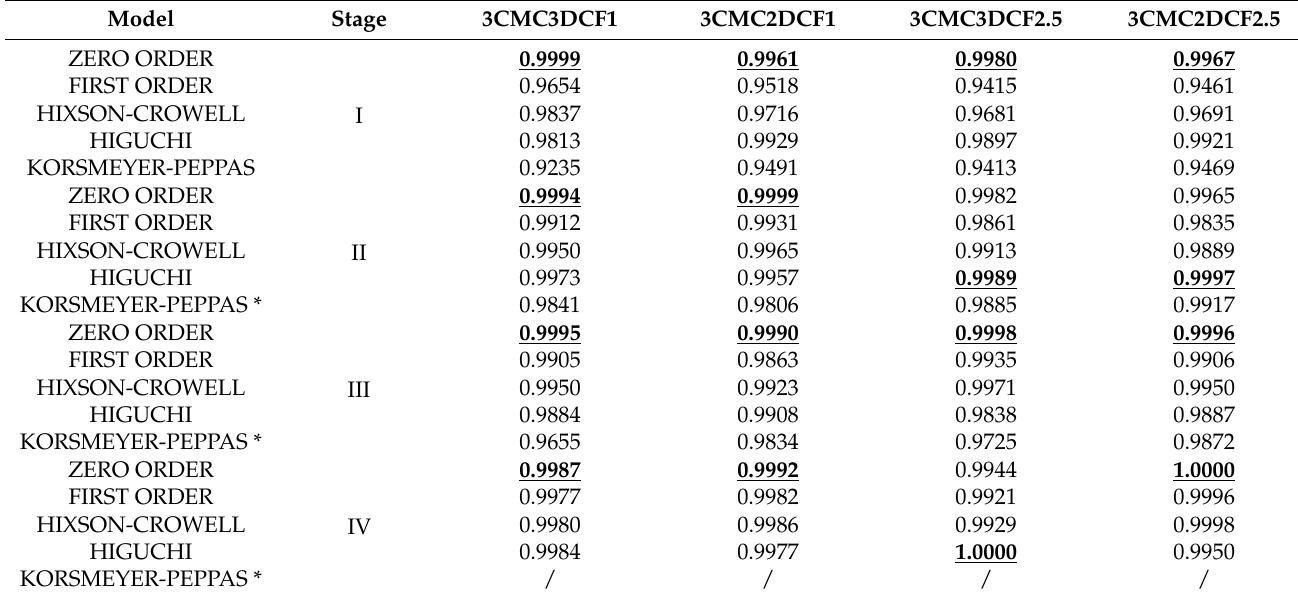
Table 3. Mathematical release model determination by comparing the fitting parameter R 2 . The bold underlined values represent the best fit and hence the most suitable model to describe the respective release stages for the four tested